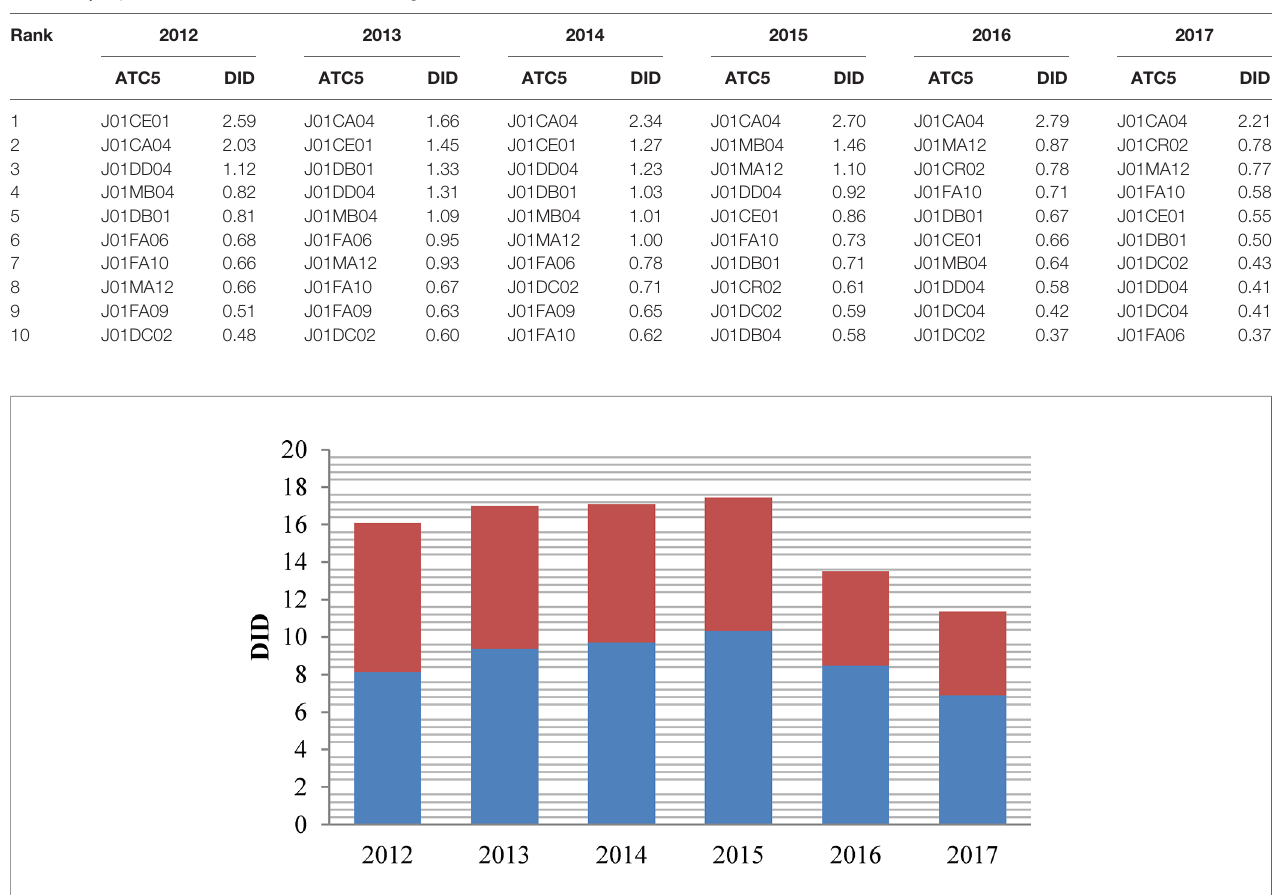
TABLE 2 | Top 10 most used antibiotics in Shandong, 2012 – 2017.